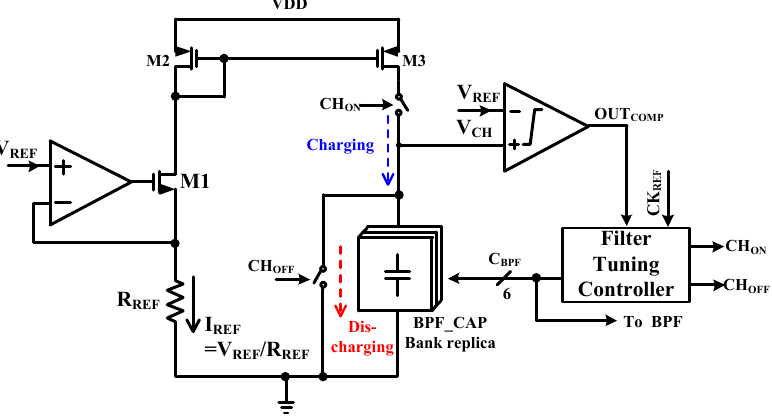
Figure 10. Schematic of the RC filter tuning circuits.